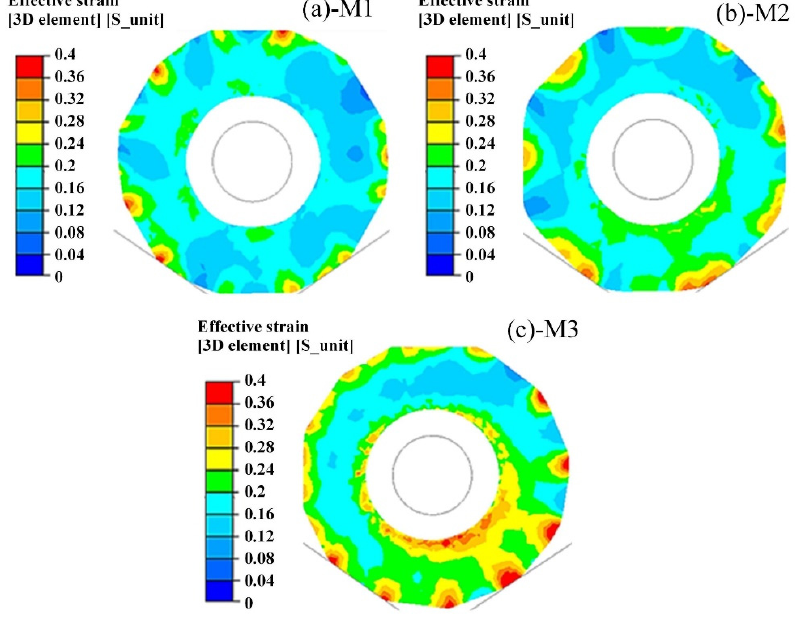
Figure 11. Effective strain distribution under different rotation angle methods: ( a ) M1; ( b ) M2; ( c ) M3.